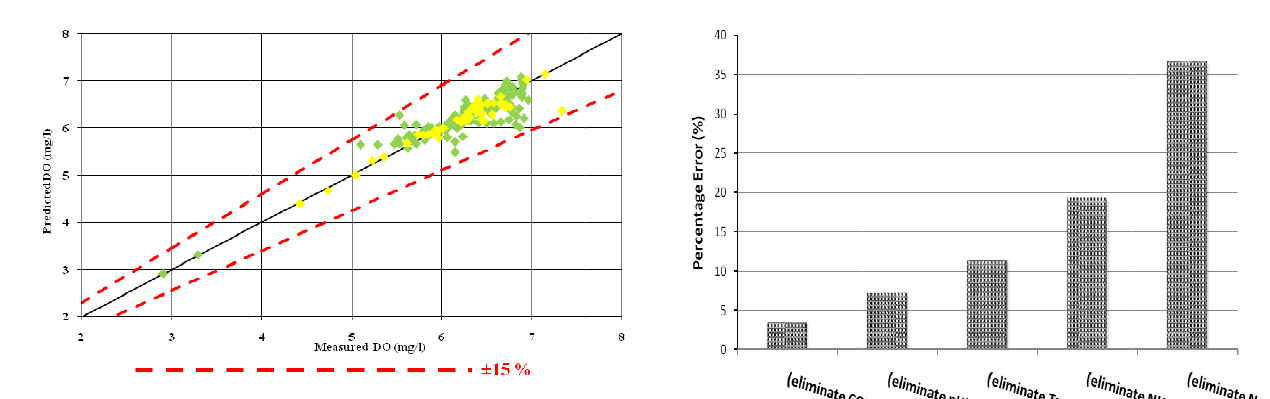
Fig. 8: A scatter diagram of the predicted versus observed DO for validation (in green dot) and testing (in yellow dot).